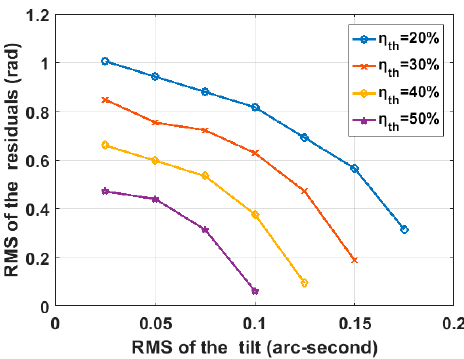
Figure 8. Residual control range of adaptive optics (AO) system under different coupling thresholds.